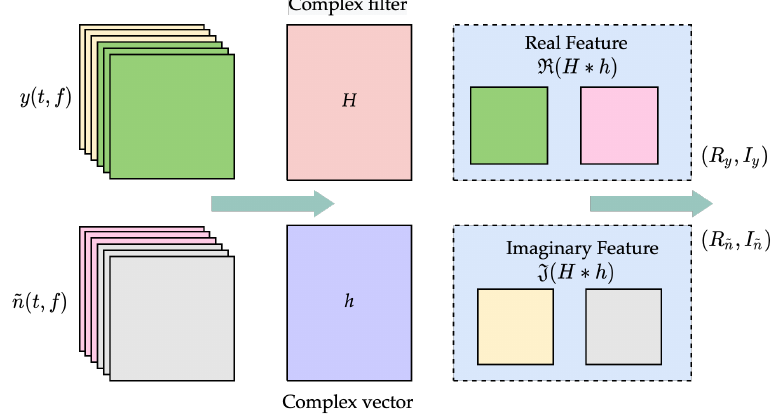
Figure 7. Convolutional structure of complex processing